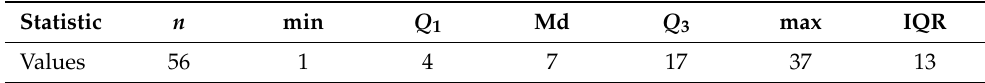
Table 3. Descriptive statistics for the student enrollment